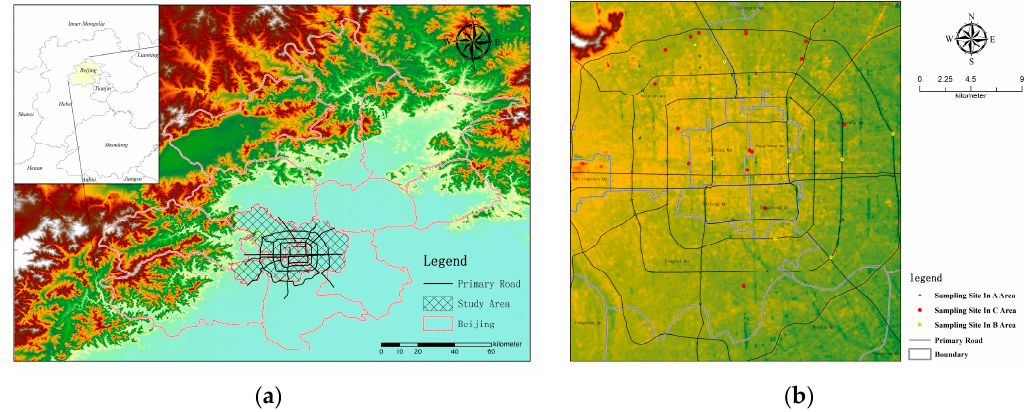
Figure 1. Location of ( a ) the study area and ( b ) sampling point distribution.